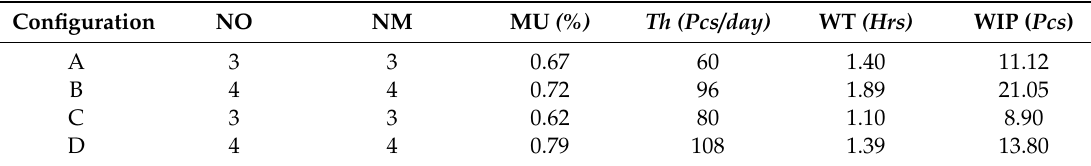
Table 4. Performance indicators of configurations.